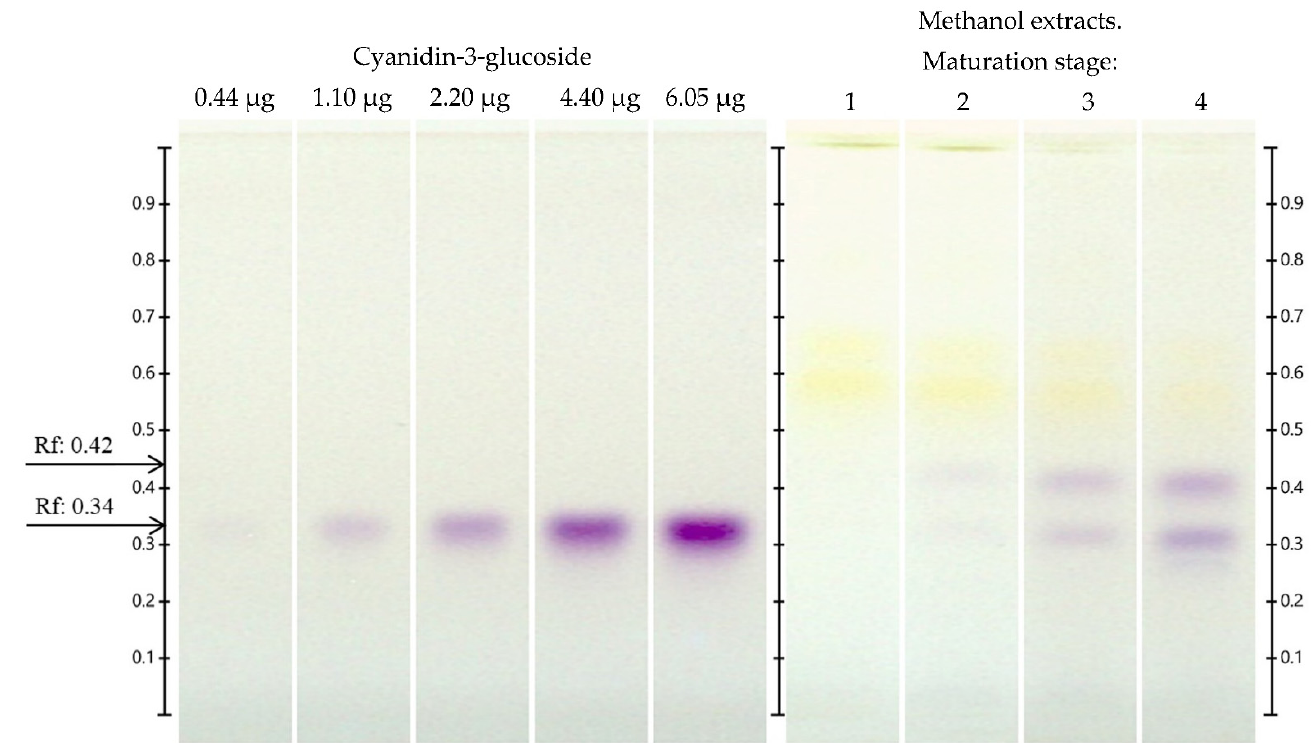
Figure 4. Quantification of cyanidin-3-glucoside by HPTLC in extracts of Vaccinium stenophyllum Steud. fruits, taken under white light, after derivatization with NP. Cyanidin 3-glucoside was applicated on different volumes as a 5-point calibrated (0.4, 1.0, 2.0, 4.0, and 5.5 µL, equivalent to 0.44, 1.10, 2.20, 4.4 and 6.05 µg; y = − 3.100 × 10 − 3 x 2 + 6.82 × 10 − 2 x − 1.480 × 10 − 2 , R 2 = 0.9998). Vaccinium